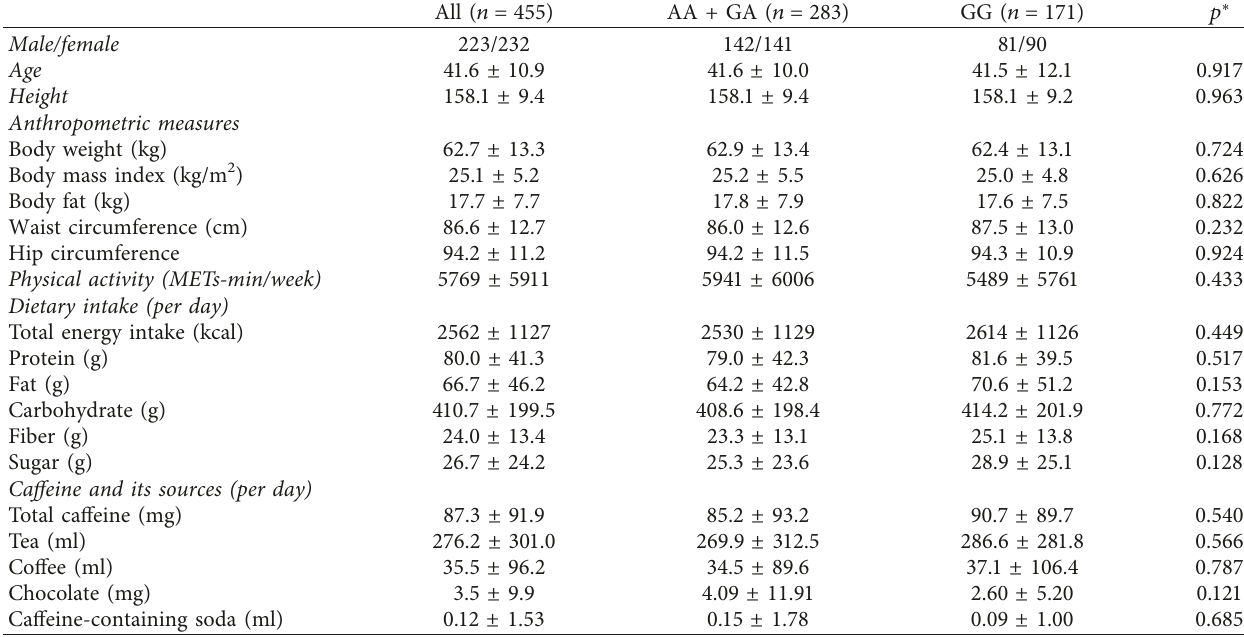
Table 1: Characteristics of subjects.